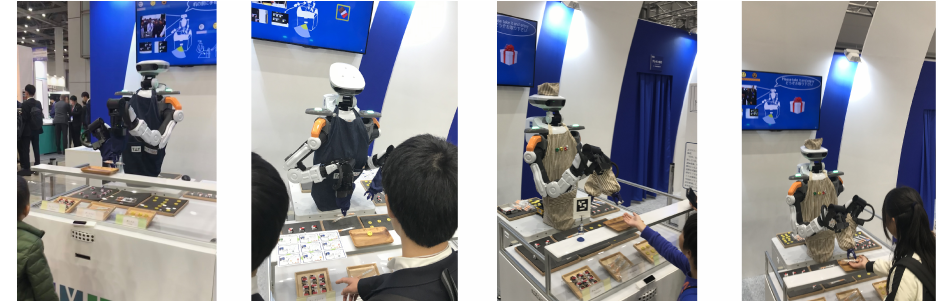
Figure 8. Example of interaction between a ROS-based robot and humans in a international robot